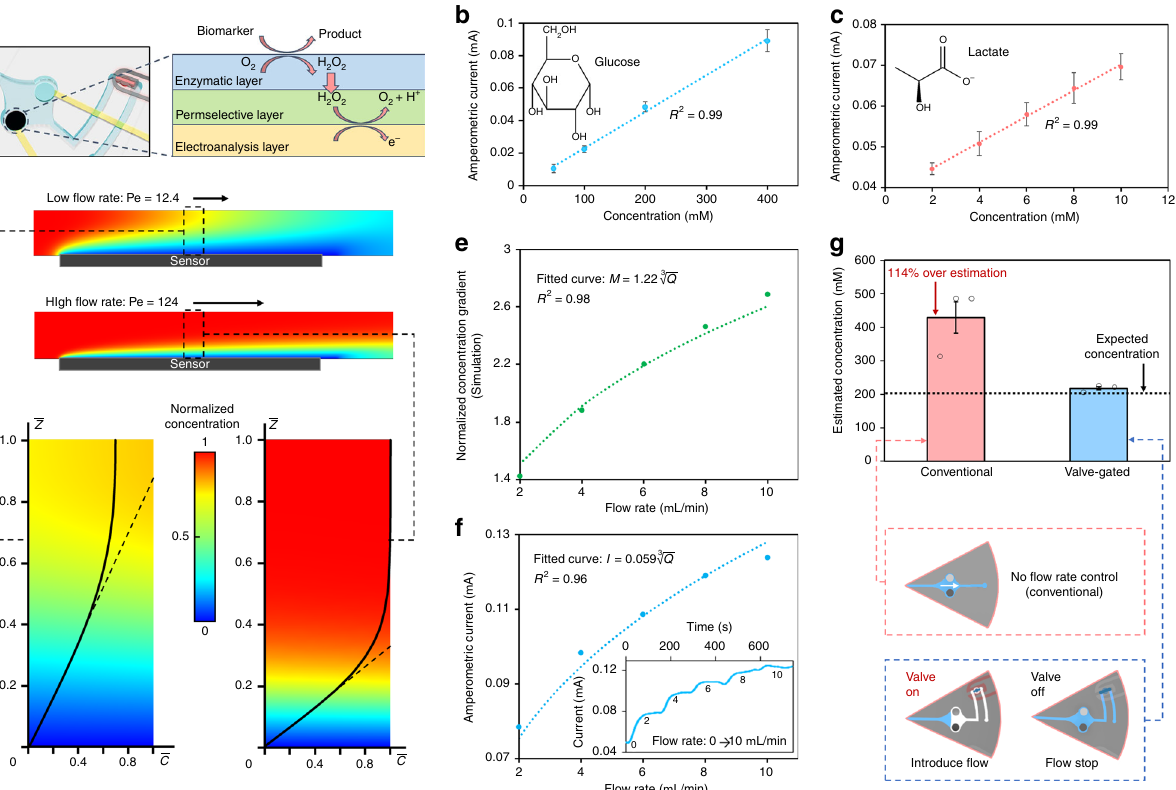
Fig. 4 Demonstration of fl ow rate-undistorted biomarker analysis. a Reaction schematic of the developed sensor (embedded within a valve-gated compartment). Current response to target analytes for b a glucose sensor and c a lactate sensor. Error bars, mean±s.e ( n = 3 measurements from different sensors). d Simulated analyte concentration (gradient) pro fi les for relatively low and high fl ow rate conditions (low fl ow rate: Q = 1 µ Lmin − 1 , resulting in Pe = 12.4, high fl ow rate: Q = 10 µ Lmin − 1 , resulting in Pe = 124, assuming a channel transverse width of 2mm and analyte diffusivity constant of 6.7×10 − 6 cm 2 s − 1 ). The annotated dashed lines tangent to the normalized concentration curves indicate the local analyte concentration gradient for the respective case. e Simulated local analyte concentration gradient at various fl ow rates (the values are normalized to that obtained for the case of 1 µ Lmin − 1 ). The curve fi tted line indicates p ffiffiffiffi Q 3 relationship. f Measured amperometric current response of a glucose sensor to 200 µ M glucose solution introduced at that simulated data points present a various fl ow rates. The inset fi gure shows the corresponding measured real-time amperometric current response in the presence of progressively increasing p ffiffiffiffi fl ow rate (from 0 to 10 μ Lmin − 1 ). The curve fi tted line indicates that simulated data points present a Q 3 relationship. g Comparison of the estimated glucose concentration of a 200 µ M glucose solution introduced at 5 µ Lmin − 1 (no valve) and 0 µ Lmin − 1 (corresponding to valve-gated condition). Error bars, mean±s.e ( n = 3 measurements from different